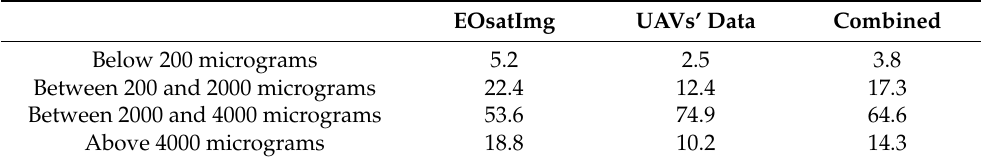
Table 7. Ash Concentration—Posterior probabilities for the isolated sensors and their